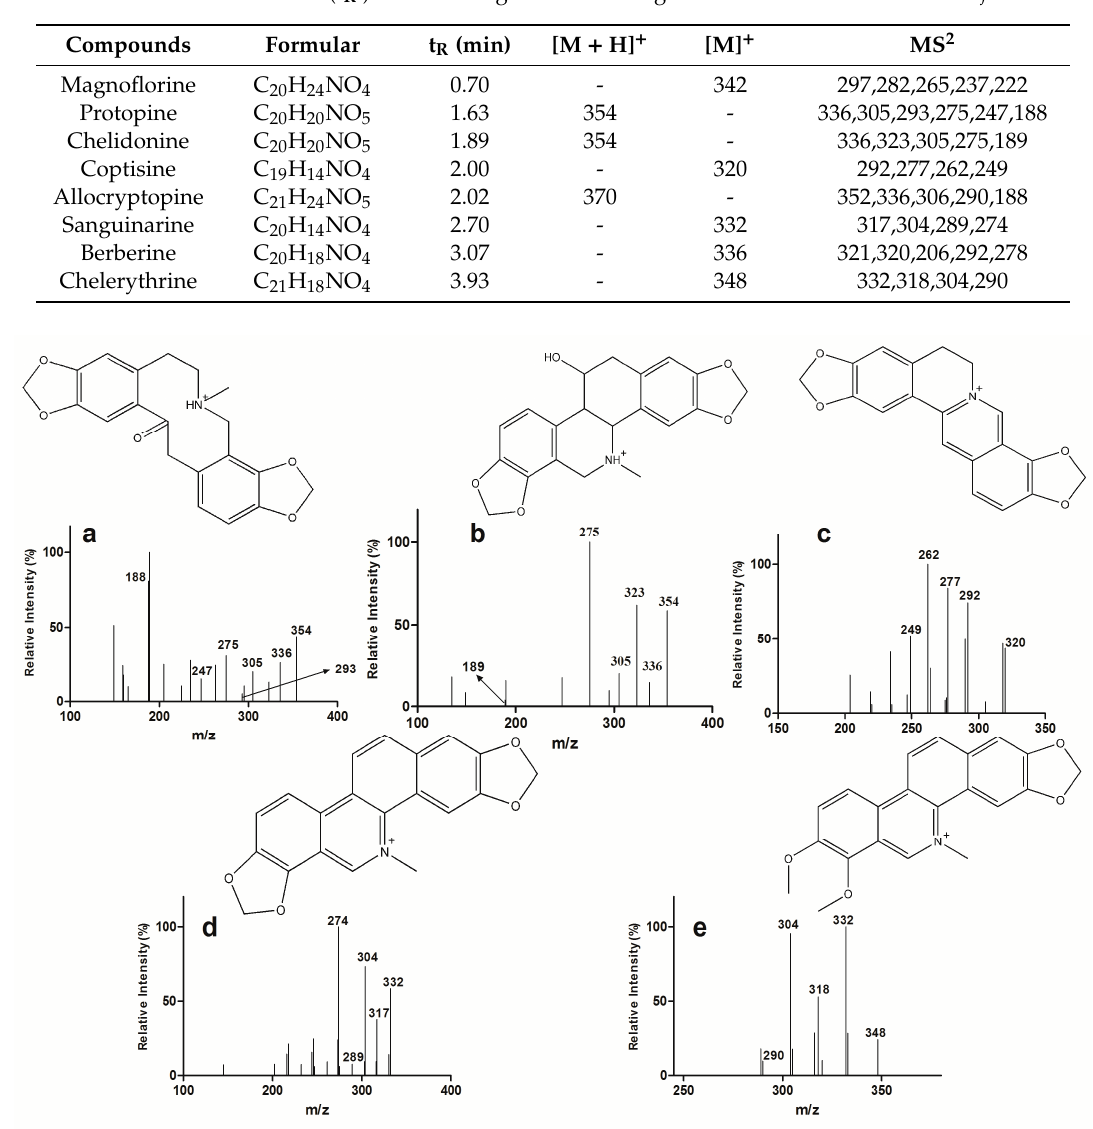
Figure 2. Full-scan product ion mass spectra of the [M + H] + ions of protopine ( a ) and chelidonine ( b ) and the [M] + ions of coptisine ( c ), sanguinarine ( d ), chelerythrine ( e ) in cell lysates after coincubation with Ch. majus for 30 min.